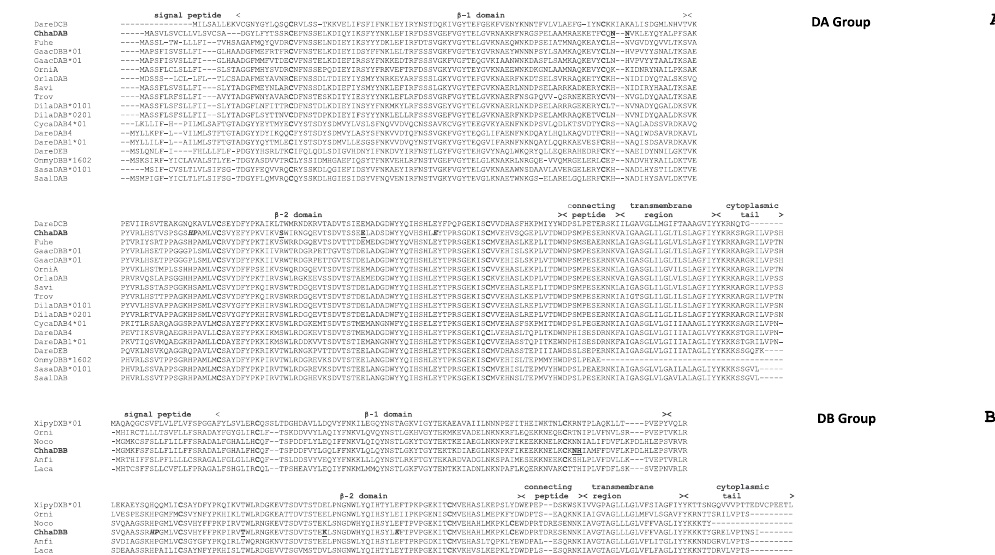
Figure 1. ( A ) Amino acid sequence alignment of the predicted icefish MHC II β Chha-DAB with selected DA group MHC sequences. The position of the cysteine residues found in the different sequences is shown in bold along the sequences. The amino acid residues potentially involved in binding with antigen peptides and CD4 are highlighted in bold and underlined, the ones potentially involved in interactions with MHC class II α chain are in bold and italics. Accession numbers: Danio rerio (zebrafish) AAA87894.1 (DareDCB); Chionodraco hamatus (icefish) KY173352 (ChhaDAB); Fundulus heteroclitus (mummichog) XP_012715816.2 (Fuhe); Gasterosteus aculeatus (stickleback) AAU01920.1 (GaacDBB * 01); Gasterosteus aculeatus (stickleback) AAU01918.1 (GaacDAB * 01); Oreochromis niloticus (Nile tilapia) XP_003459301.2 (OrniA); Oryzias latipes (medaka) BAA94279.1 (OrlaDAB); Sander vitreus (Walleye) AAO19848.1 (Savi); Trachinotus ovatus (pompano) APD68814.1 (Trov); Dicentrarchus labrax (sea bass) AM113466 (Dila-DAB * 0101); Dicentrarchus labrax (sea bass) AM113467 (Dila-DAB * 0201); Cyprinus carpio (common carp) CAA64709.1 (CycaDAB4 * 01); Danio rerio (zebrafish) AAA87891.1 (DareDAB4); Danio rerio (zebrafish) AAA50043.1 (DareDAB1 * 01); Danio rerio (zebrafish) AAA87895.1 (DareDEB); Oncorhynchus mykiss (rainbow trout) AF115531.1 (OnmyDBB * 1602); Salmo salar (Atlantic salmon) CAA49725.1 (SasaDAB * 0101); Salvelinus alpinus (Arctic char) ACI05078.1 (SalaDAB). ( B ) Amino acid sequence alignment of the predicted icefish MHC II β Chha-DBB with selected DB group MHC sequences. Accession numbers: Xiphophorus pygmaeus (Pigmy swordtail) AAS55044.1 (XipyDXB * 01); Oreochromis niloticus (Nile tilapia) XP_019220627.1 (Orni); Notothenia coriiceps (Black rockcod) XP_010785298.1 (Noco); Chionodraco hamatus (icefish) KX398847 (ChhaDBB); Anoplopoma fimbria (sablefish) ACQ58371.1 (Anfi); Lates calcarifer (Asian sea bass) XP_018541680.1